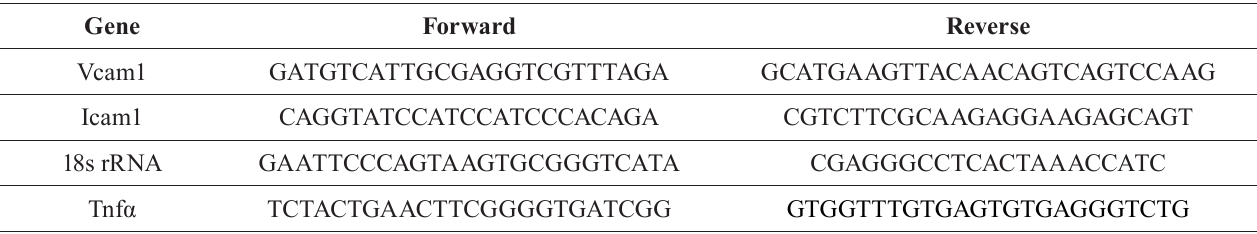
TABLE I - F orward and reverse primers of mRNA used in RT-PCR assay Gene Forward Reverse Vcam1